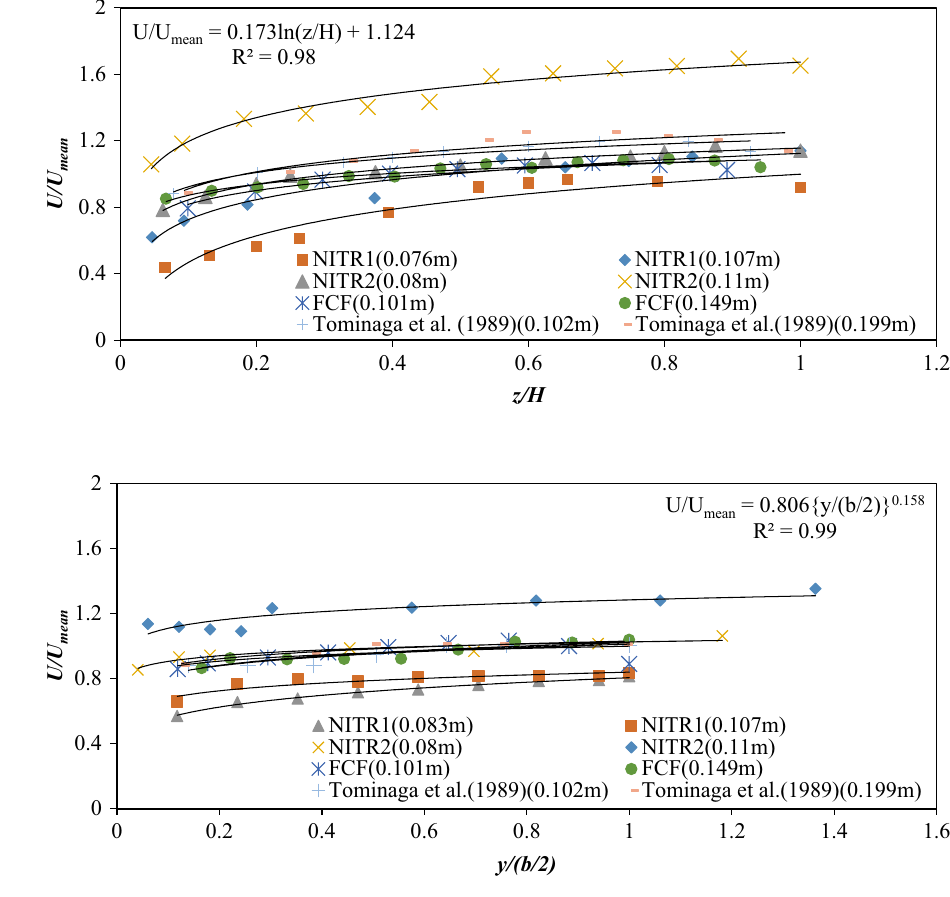
U/U = 0.173ln(z/H) + 1.124 mean R² = 0.98